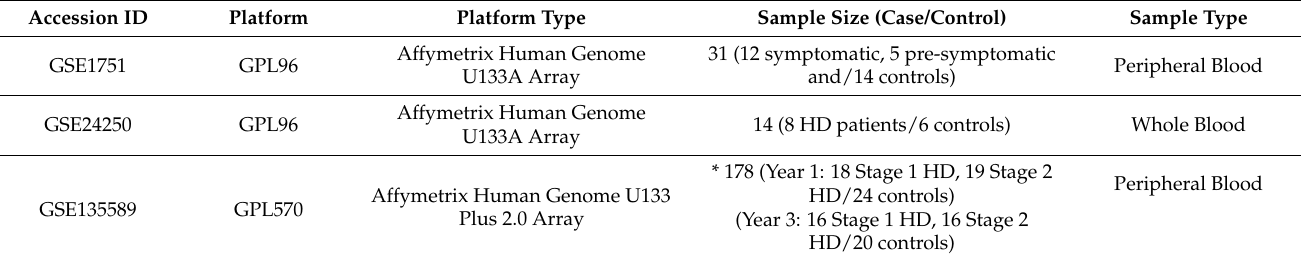
Table 1. Detailed information of the three transcriptomics datasets of HD analysed in this study.